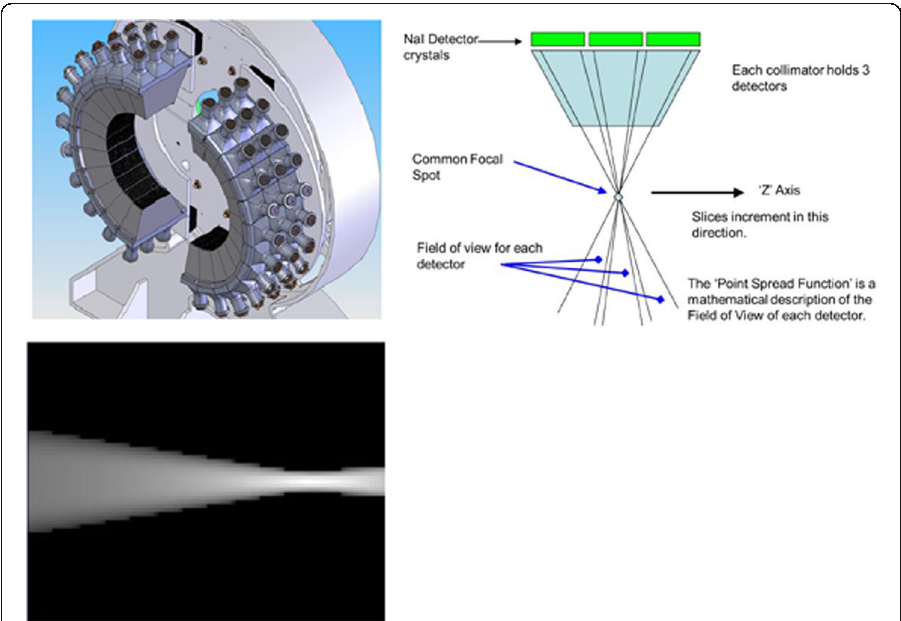
Fig. 1 Schematic representation of the InSPira HD system showing the gantry without covers (left) and the collimator configuration (right). The collimator consists of three different detectors along the z direction. The point spread function (PSF) is given by the fractional solid angle of the rays that successfully pass through the collimator. Typically, each PSF has a focal spot where the value is at its maximum (below: 2D view of one of the InSpira PSF functions) (images obtained from Neurologica,